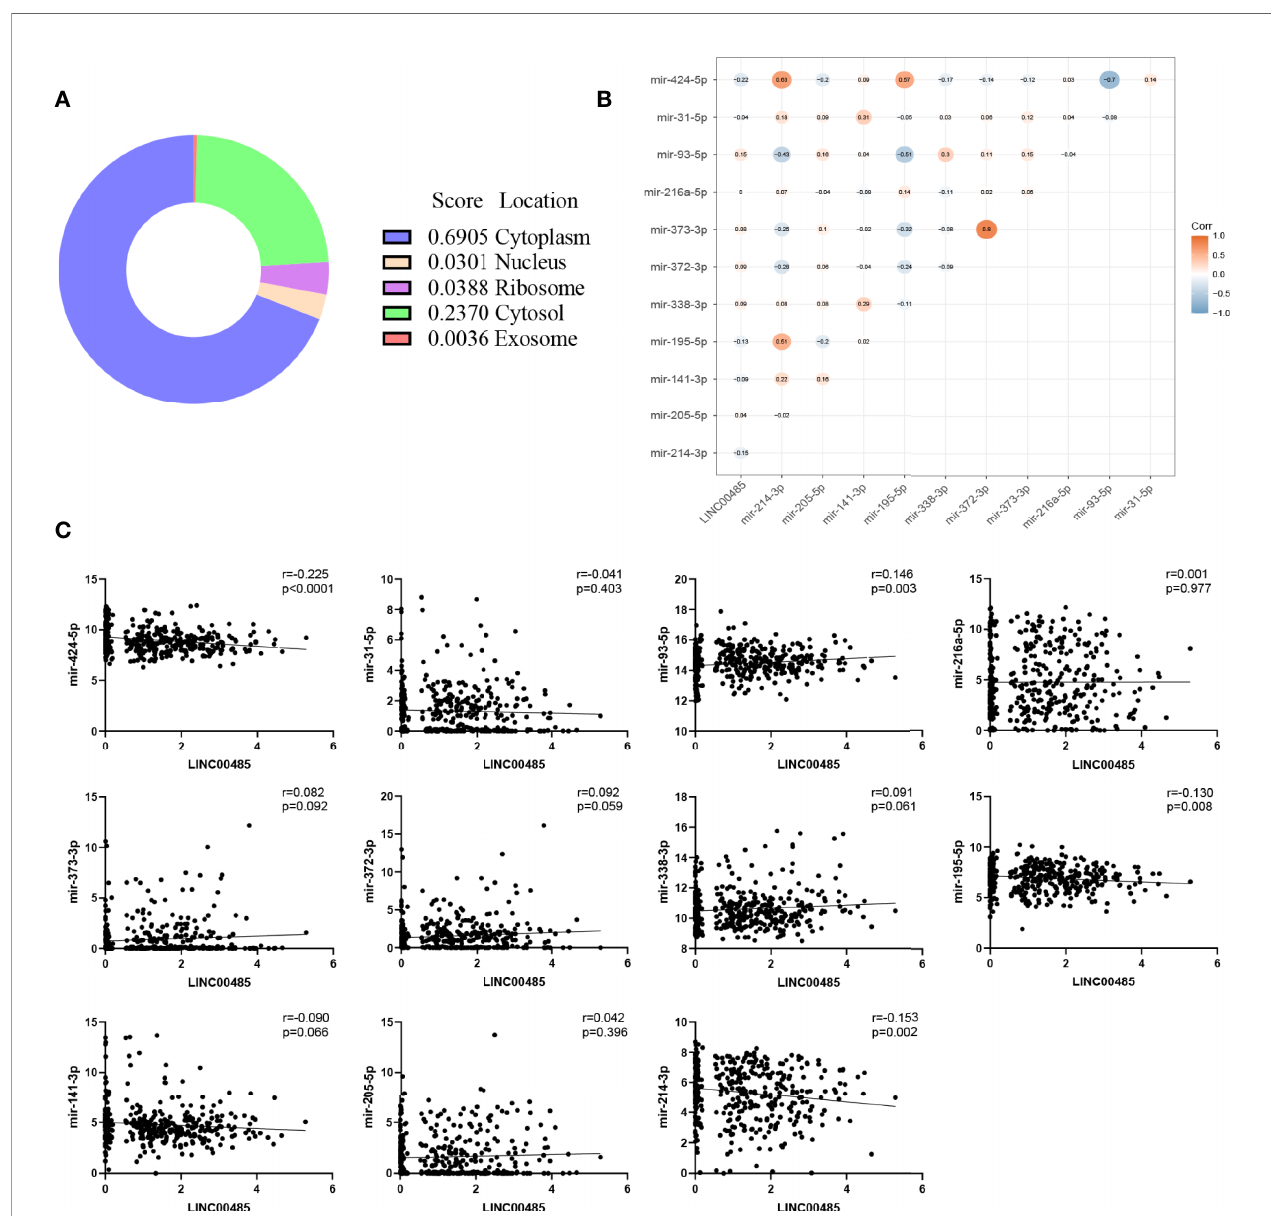
FIGURE 4 | The cellular localization of LINC00485 . (A) Subcellular location of LINC00485 predicted by LncLocator. The location is determined by the score of different subcellular components. Correlation analysis between LINC00485 and downstream miRNAs. (B) Heatmap of the correlation between expression levels of LINC00485 , miR-214-3p, miR-205-5p, miR-141-3p, miR-195-5p, miR-338-3p, miR-372-3p, miR-373-3p, miR-216a-5p, miR-93-5p, miR-31-5p, and miR-424-5p in the same HCC patients derived from TCGA database. Pearson correlation was applied to explore the relevance. The colored dots at different positions re fl ect the correlation between the corresponding molecules. The red dots indicate positive correlation while the blue dots indicate negative correlation. (C) Each scatter plot represents the correlation between LINC00485 and each downstream